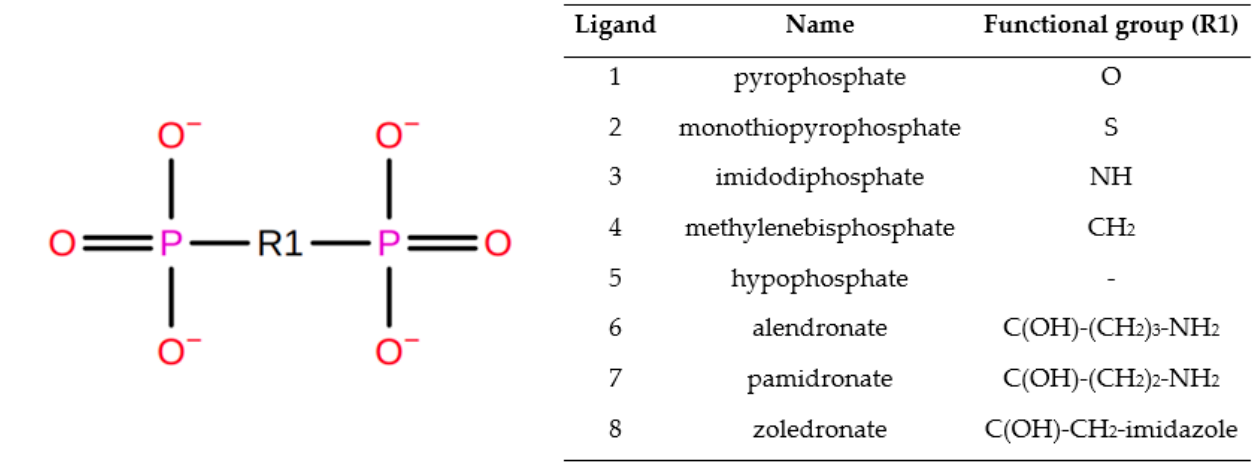
Figure 2. Series of ligands with selective modification at the phosphates connected to O-atom posi- tion.